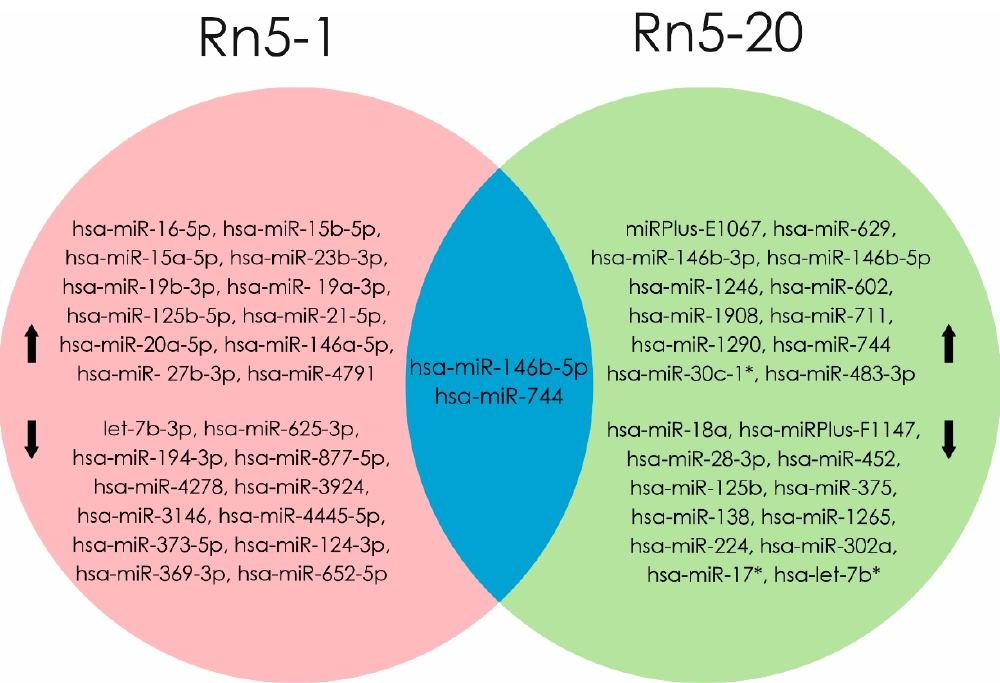
Figure 4. miRNAs profile were changed when exposed to radon in Rn5-1 cells (in the pink area). miRNAs profile were changed when exposed to radon in Rn5-20 cells (in the green area). At the intersection of these regions (blue part) indicated miRNAs, the level of which increased in both cell lines (Rn5-1 and Rn5-20). (Data from [17]). microRNAs that are associated with the development of radon-induced lung cancer are shown in bold text